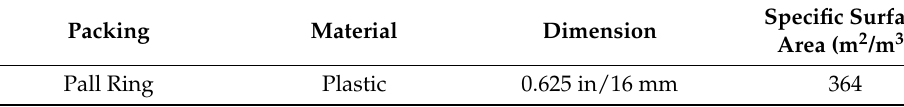
Table 3. Column Internal Characteristics.